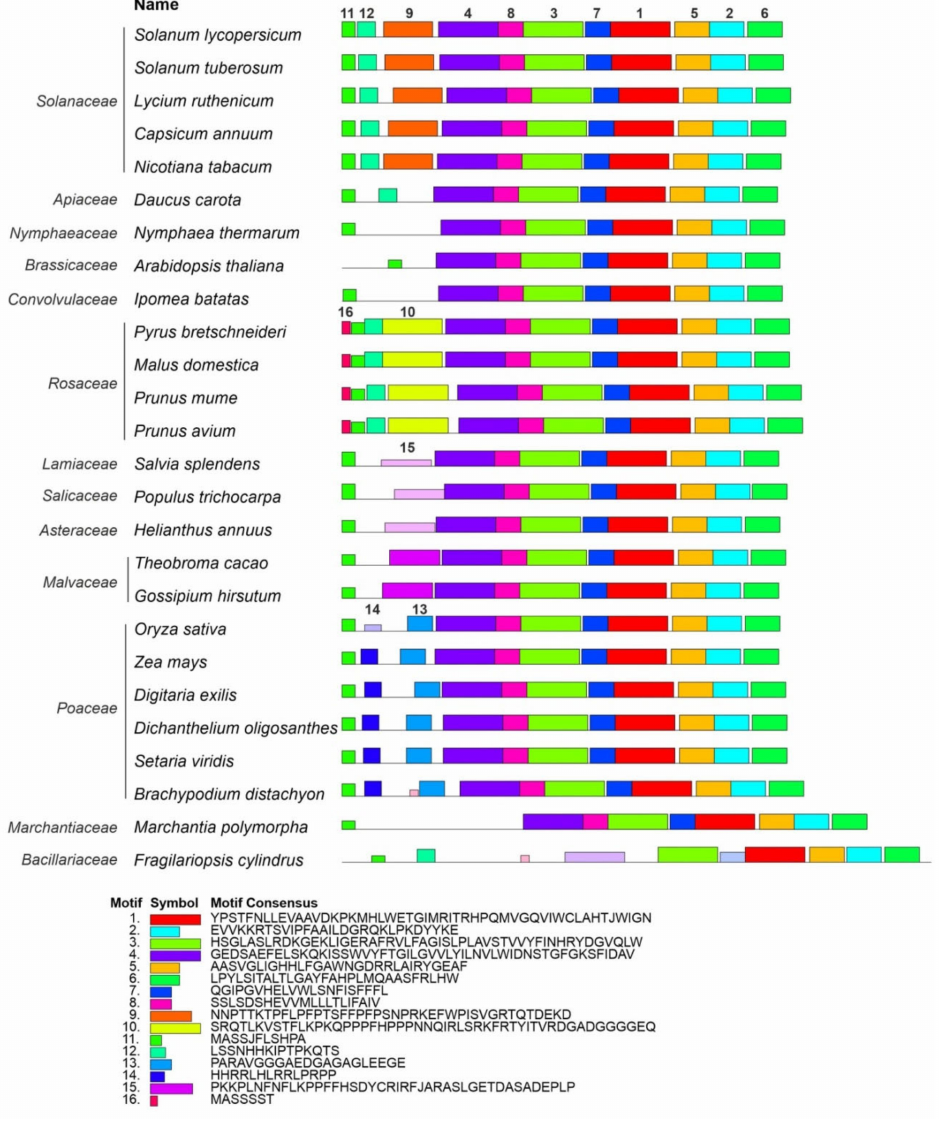
Figure 3. Distribution of conserved motifs in Z-ISO homologs of different plant species. Identification was conducted using the MEME search tool; the length of each box corresponds to that of the motif and the order of the motifs corresponds to their position in the protein. Motifs are numbered in descending order of the reliability of their